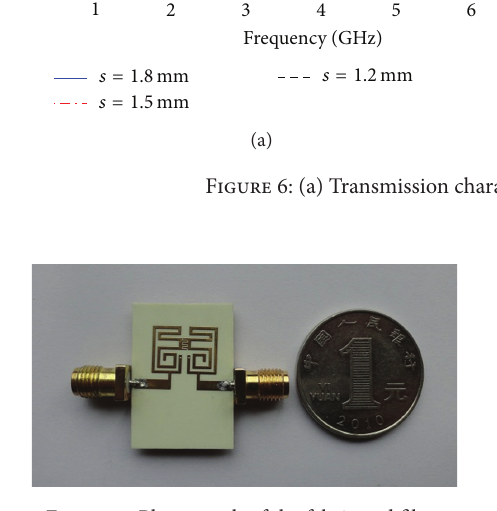
Figure 7: Photograph of the fabricated filter.